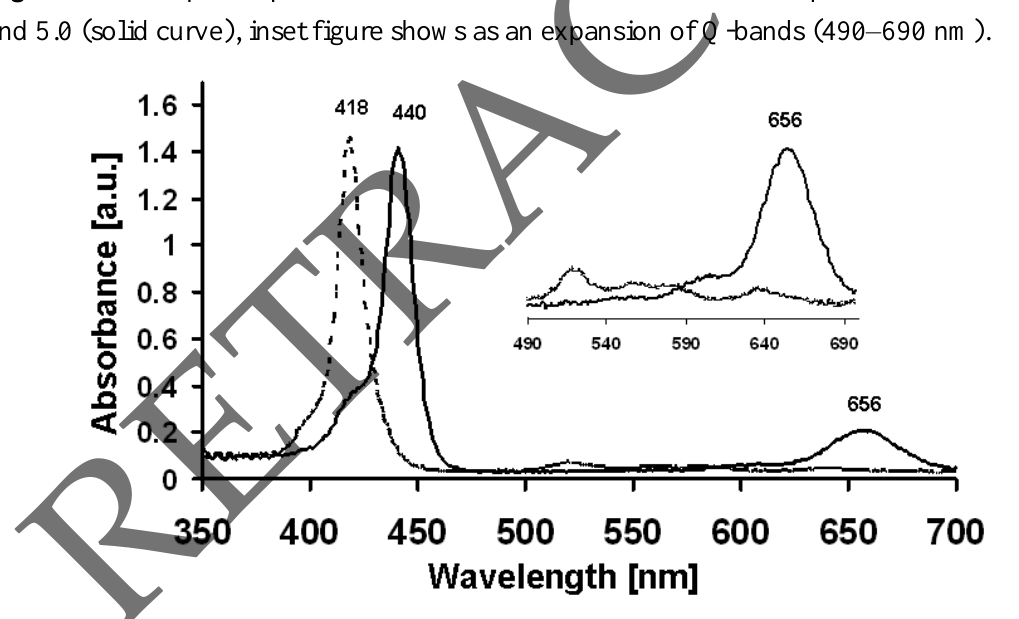
Figure 2. Absorption spectrum of OctaPhosPor 1 (1 × 10 −4 M) at pH 9.0 (broken curve) and 5.0 (solid curve), inset figure shows as an expansion of Q-bands (490–690 nm).